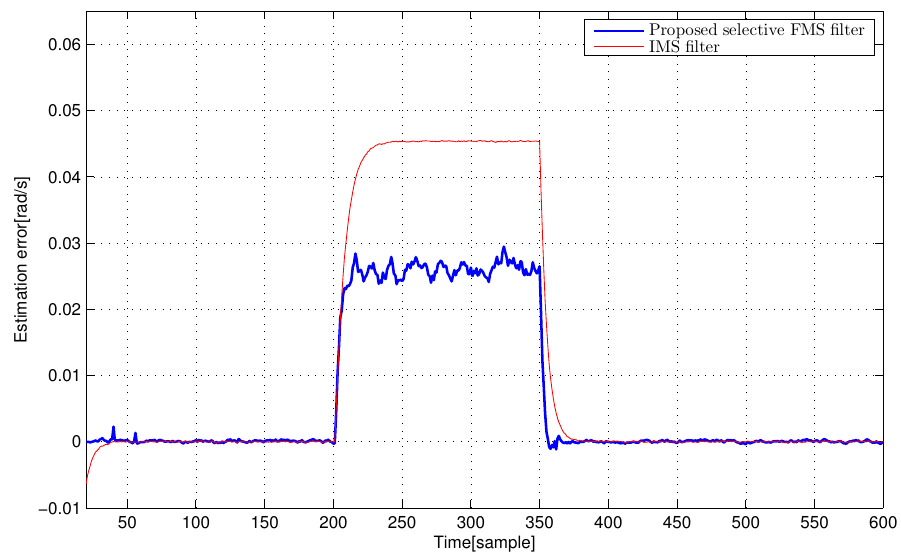
Figure 11. Estimation errors of the proposed selective FMS and IMS filters for the electric motor